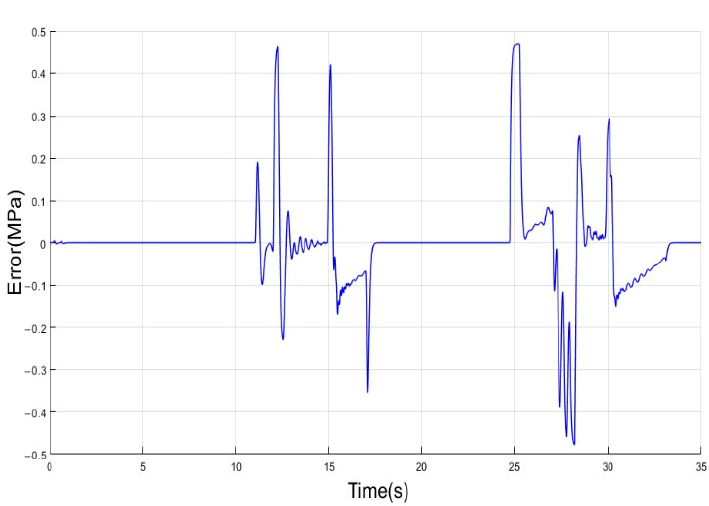
Figure 18. Pressure control effects.